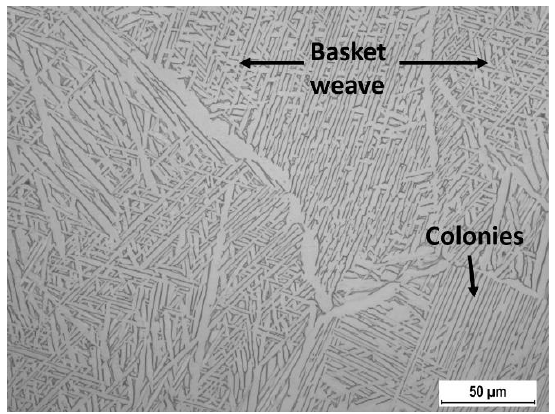
Figure 13. Different Widmanstätten structures found in Ti6Al4V.